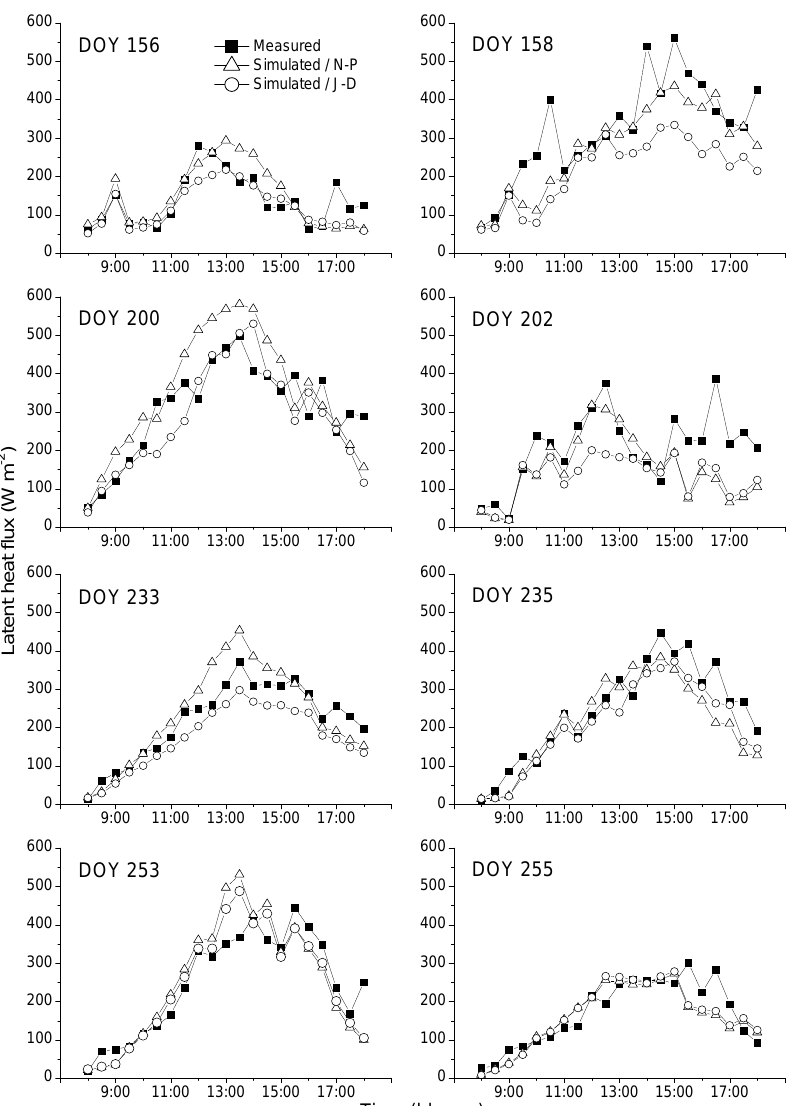
Fig. 8. Measured and modeled courses of half-hourly latent heat flux on days before and after irrigation during the maize growing season.